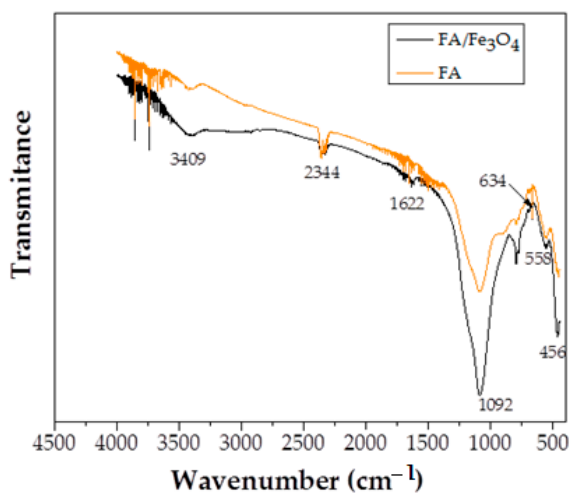
Figure 3. FTIR spectra of FA and FA/Fe 3 O 4.